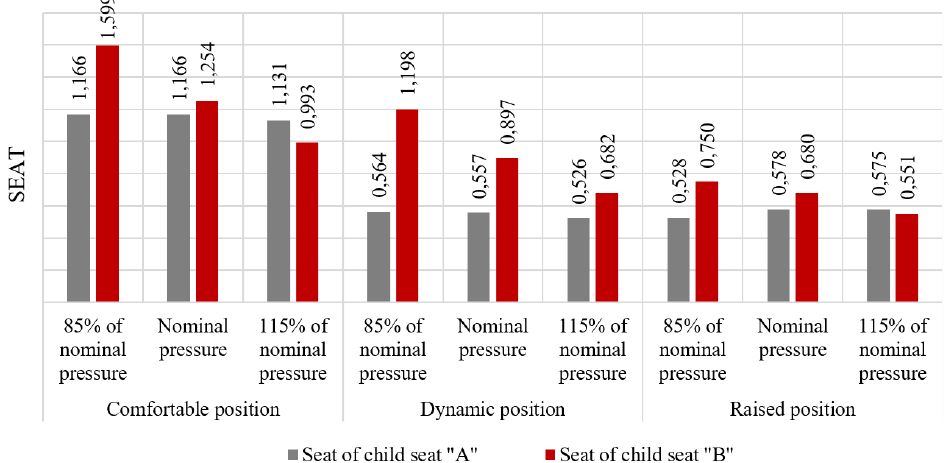
Figure 20: SEAT indicator on the seat of the tested child seats with a mass of 15 kg